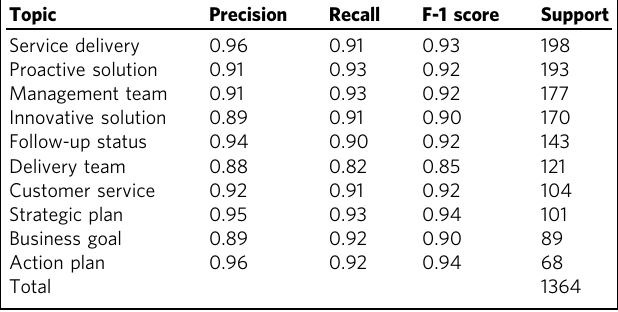
Table 3 Classi fi cation accuracy of the top 10 positive topics.